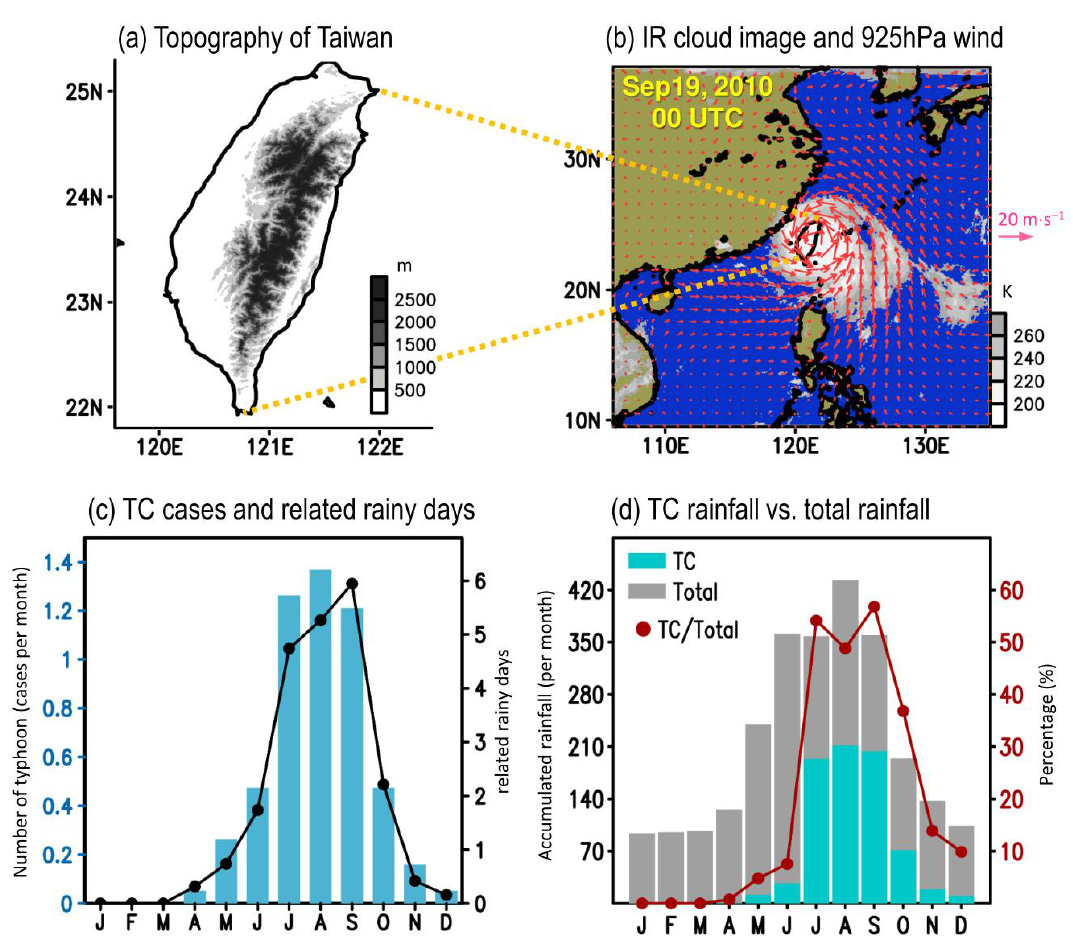
Figure 1. ( a ) Topography of Taiwan. ( b ) Infrared cloud image obtained from Gridded Satellite B1 Observations (https://www.ncdc.noaa.gov/gridsat/) and 925 hPa wind filed obtained from ERA5 reanalysis (https://www.ecmwf.int/), for a representative typhoon event that occurred on 19 September 2010, 00 UTC. ( c ) Annual evolution of monthly mean of typhoon-related (TC) cases (bars) and TC rainy days (black line) affecting Taiwan, averaged within the period of 2000 – 2018. The methods used for identifying TC cases and TC rainy days are documented in Section 2. Corresponding to ( c ), ( d ) shows the monthly accumulation of rainfall for TC rainy days (blue bars), total rainy days (gray bars), and percentage of TC rainfall accumulation relative to total rainfall (red line), estimated from the CWB rain gauge data averaged within the period of 2000 – 2018.